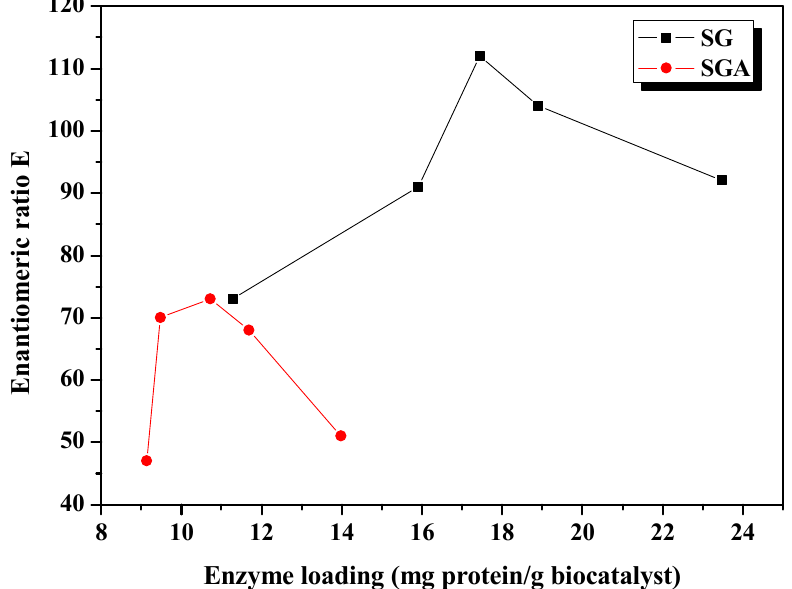
Figure 2. Influence of enzyme loading on the enantioselectivity of CaLB lipase immobilized by sol-gel entrapment (SG) or sol-gel entrapment combined with adsorption (SGA), in acylation of 2-octanol at 40 °C, calculated at 6 h reaction